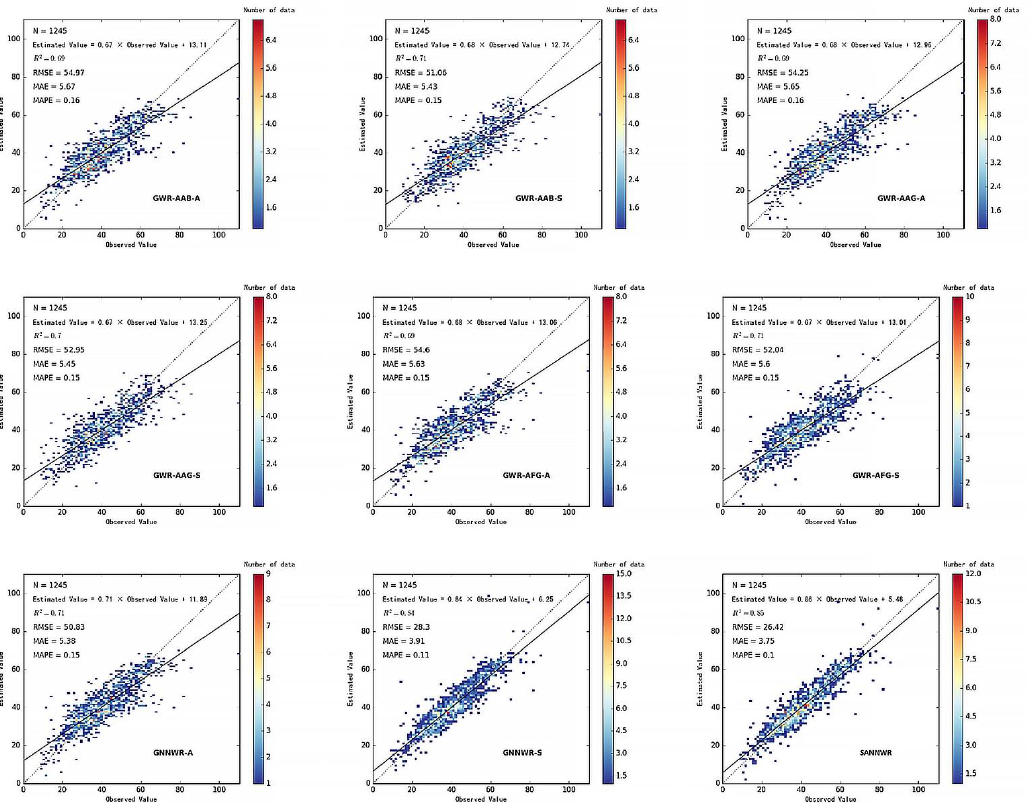
Figure 7. Scatter plots of predicted and actual values in the validation set.